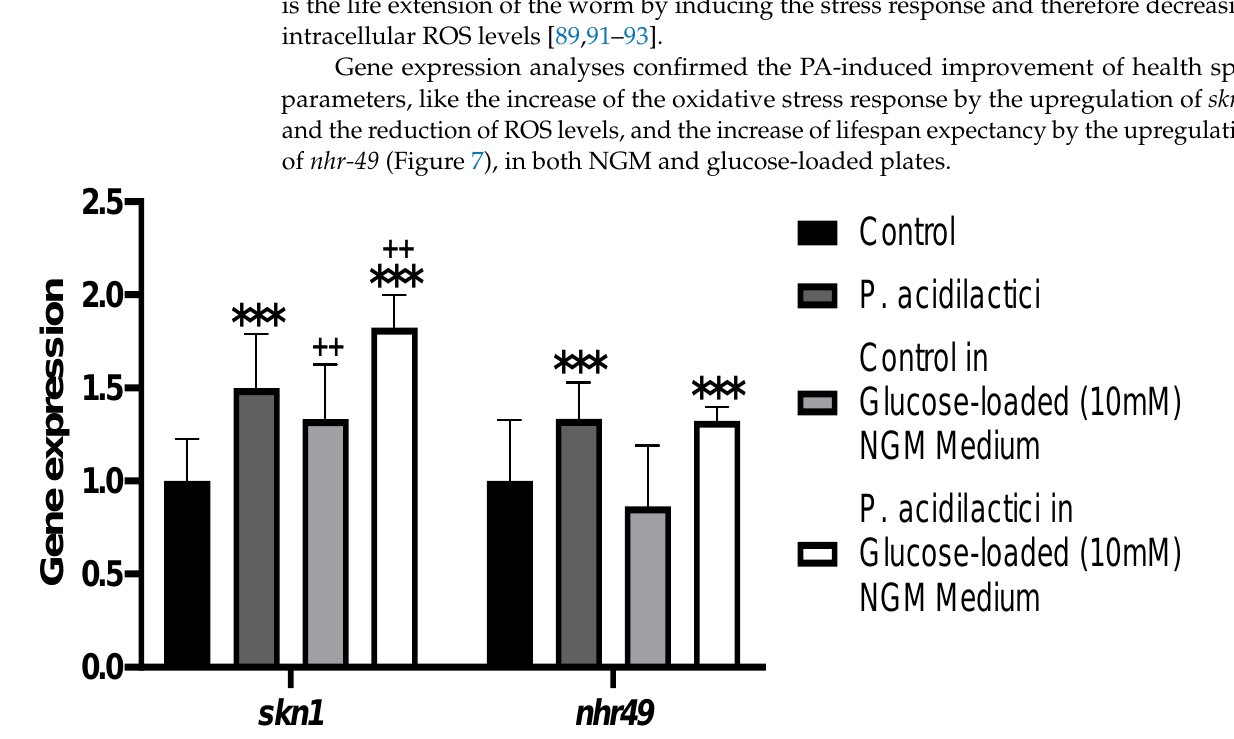
Figure 7. Gene expression analysis quantified by real-time PCR (qPCR) in C. elegans . Gene expression levels were normalized to the housekeeping gene ( pmp-3 ). Data are expressed using the 2−∆∆Ct method. A two-way ANOVA (main effects: pA1c, glucose and their interaction), followed by a Student´s t-Test was carried out to evaluate statistical differences between groups: Two-way ANOVA results when pA1c factor is significant: *** p < 0.001. Two-way ANOVA results when glucose factor is significant: ++ p < 0.01.